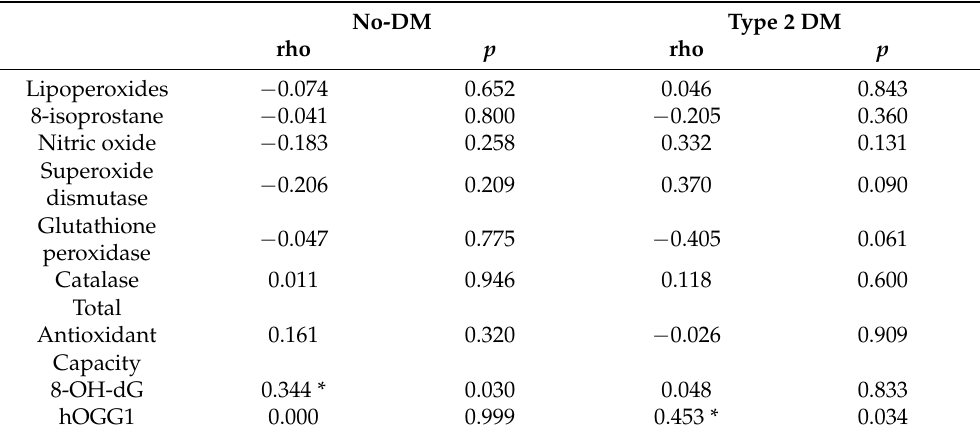
Table 3. Spearman’s correlation coefficient between markers of OS and the type of PT with and without type 2